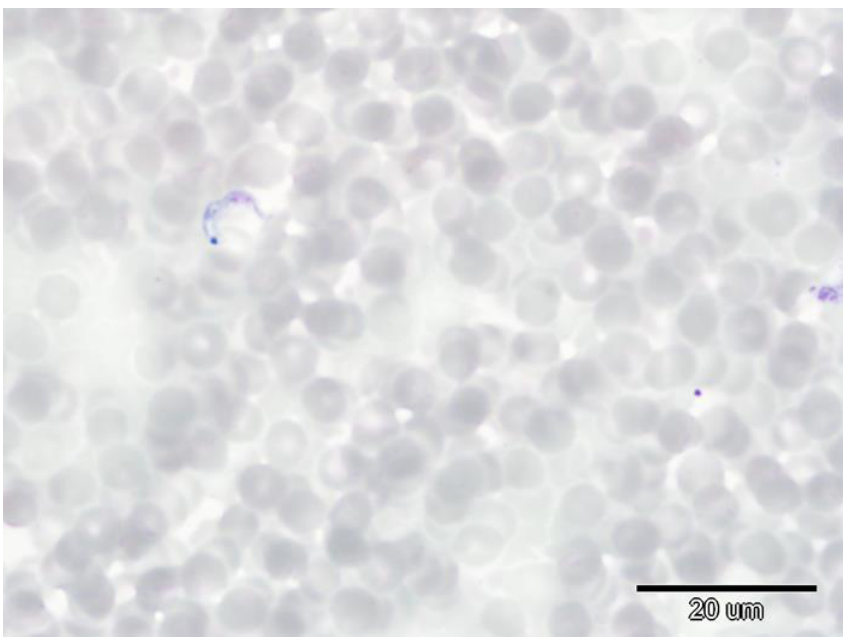
Figure 1. Trypanosoma dionisii in a blood smear from a Noctule bat female in hibernation (Giemsa staining, magnification of 1000×).